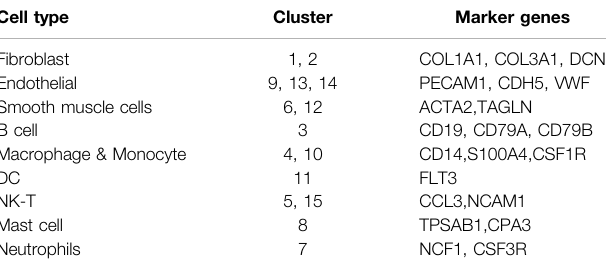
TABLE 1 | Marker genes in different cell